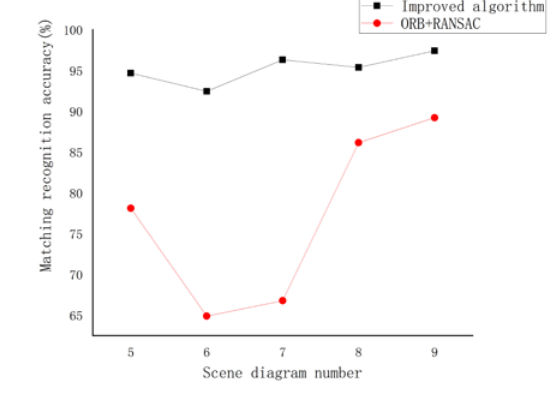
Fig. 2. Line graph of algorithm matching recognition